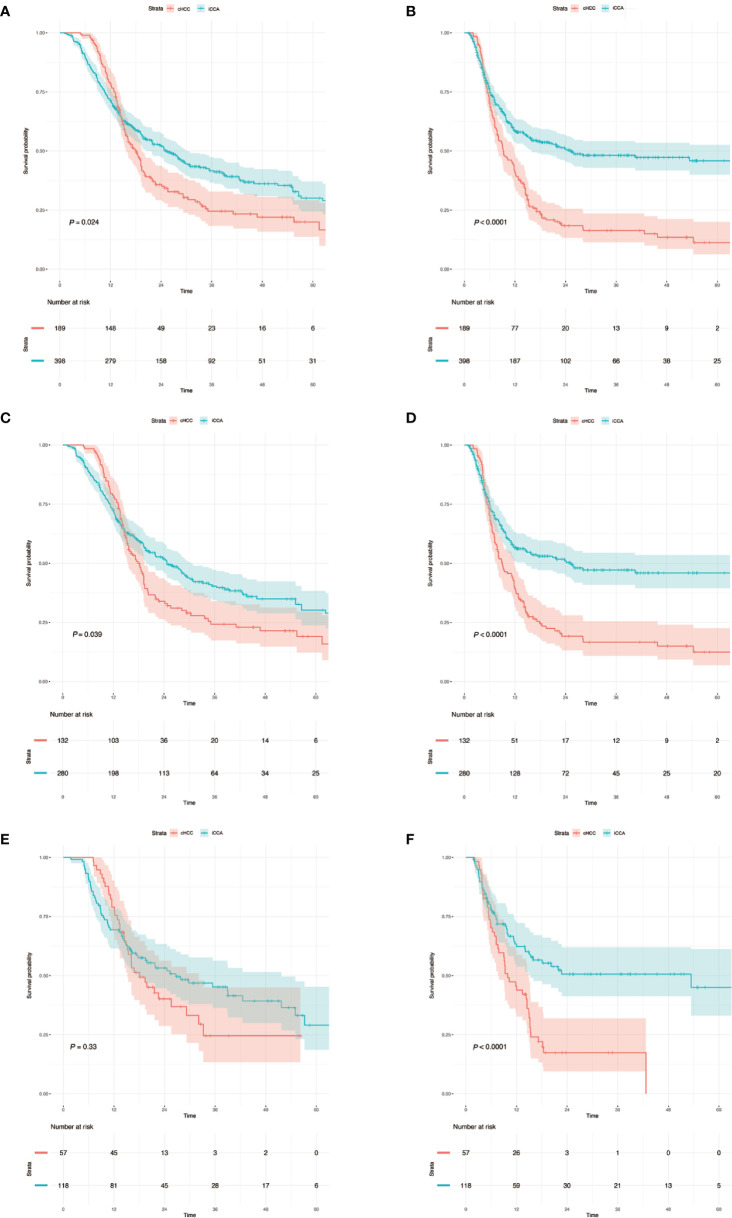

(A, C, E) Kaplan–Meier analysis of overall survival for cHCC and iCCA in the whole sets, training sets and validation sets. (B, D, F) Kaplan–Meier analysis of recurrence-free survival and overall survival for cHCC and iCCA in the whole sets, training sets and validation sets. The number at risk refers to the number of patients who have not relapsed at the corresponding time point. cHCC, combined hepatocellular cholangiocarcinoma; iCCA, intrahepatic cholangiocarcinoma.